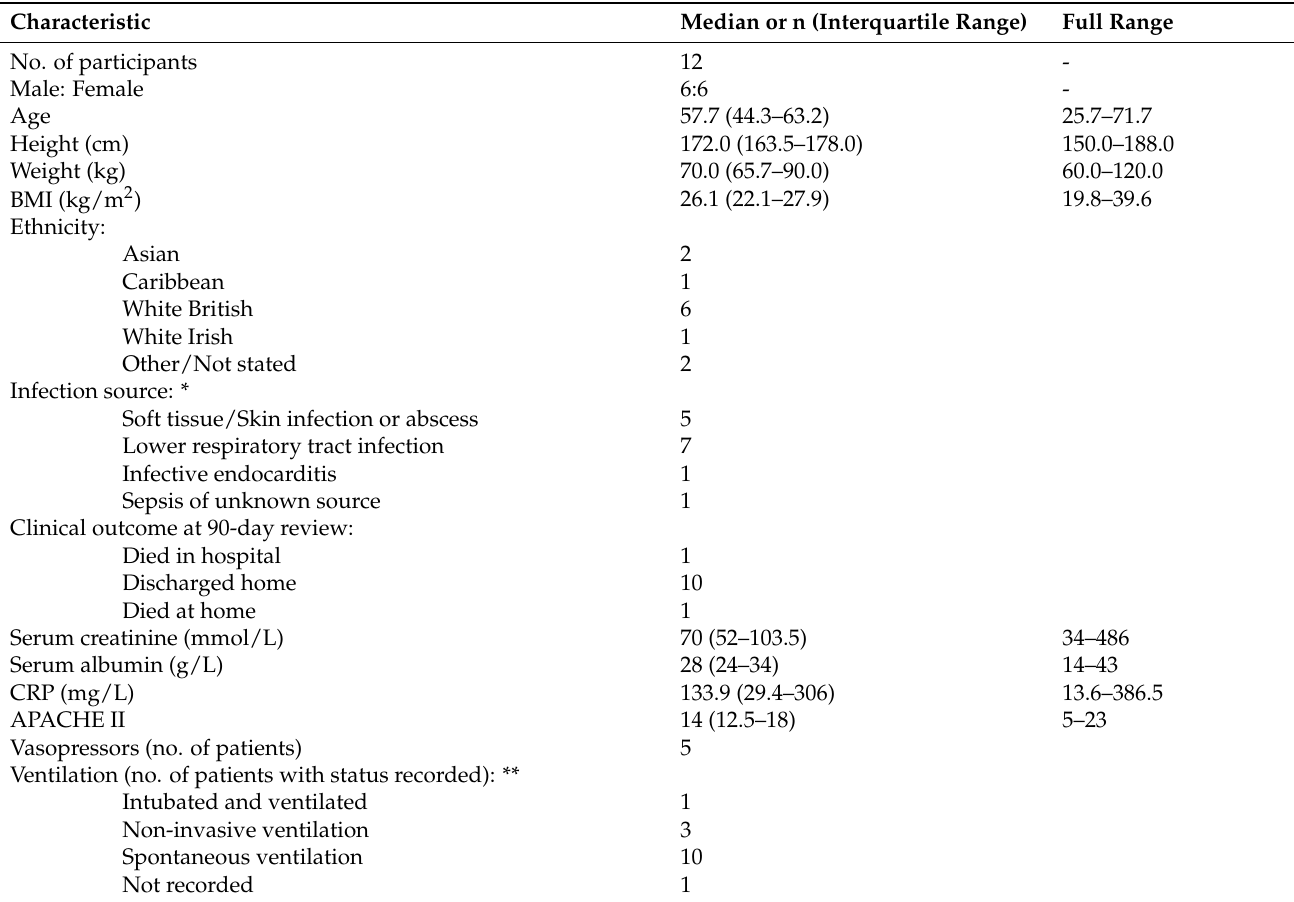
Table 1. Summary of patient